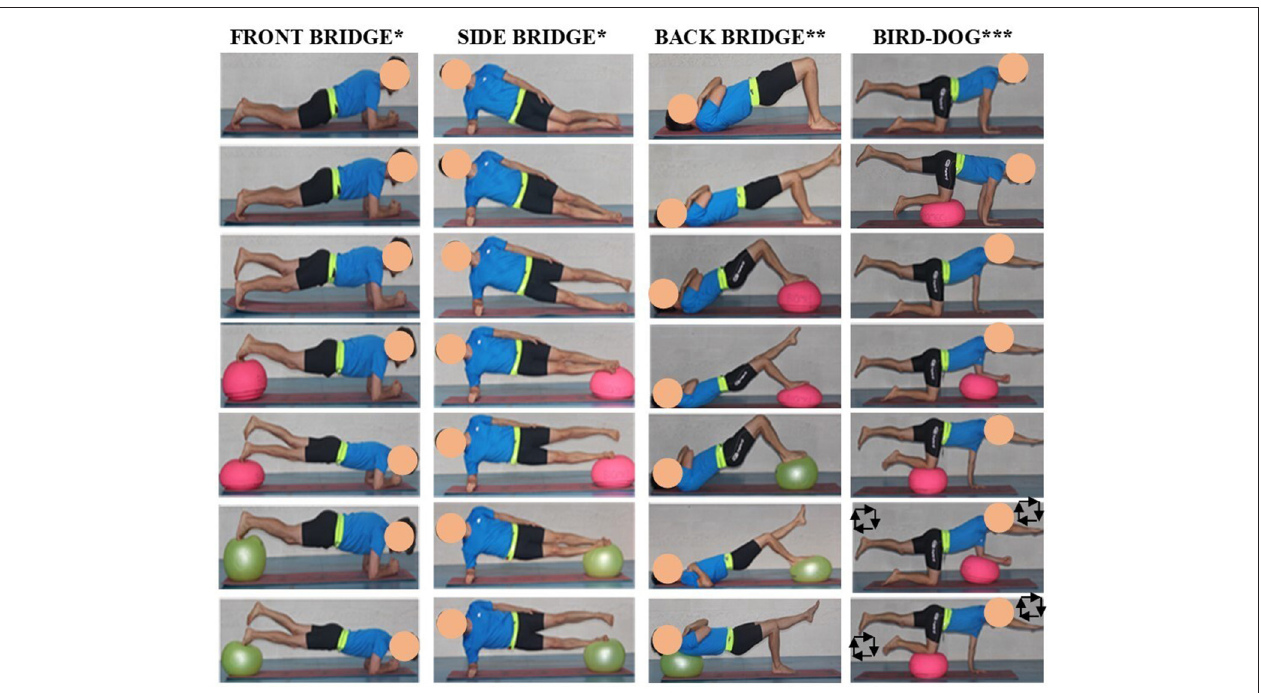
FIGURE 1 | Core stability exercises. * Variations of the front and side bridge exercises: (1) short front/side bridge; (2) long front/side bridge; (3) front/side bridge with single leg support; (4) front/side bridge with double leg support on a hemisphere ball; (5) front/side bridge with single leg support on a hemisphere ball; (6) front/side bridge with double leg support on a fit ball; (7) front/side bridge with single leg support on a fit ball; ** Variations of the back bridge exercise: (1) short back bridge; (2) back bridge with single leg support; (3) back bridge with double leg support on a hemisphere ball; (4) back bridge with single leg support on a hemisphere ball; (5) back bridge with double leg support on a fit ball; (6) back bridge with single leg support on a fit ball; (7) back bridge with single leg support and with the upper-back on a fit ball; *** Variations of the bird-dog exercise: (1) three-point position with an elevated leg; (2) three-point position with an elevated leg and the contralateral knee on a hemisphere ball; (3) classic two-point bird-dog position with elevated contralateral leg and arm; (4) two-point bird-dog position with the forearm on a hemisphere ball; (5) two-point bird-dog position with the knee on a hemisphere ball; (6) two-point bird-dog position with the forearm on a hemisphere ball while drawing squares in the air with the elevated limbs; (7) two-point bird-dog position with the knee on a hemisphere ball while drawing squares in the air with the elevated